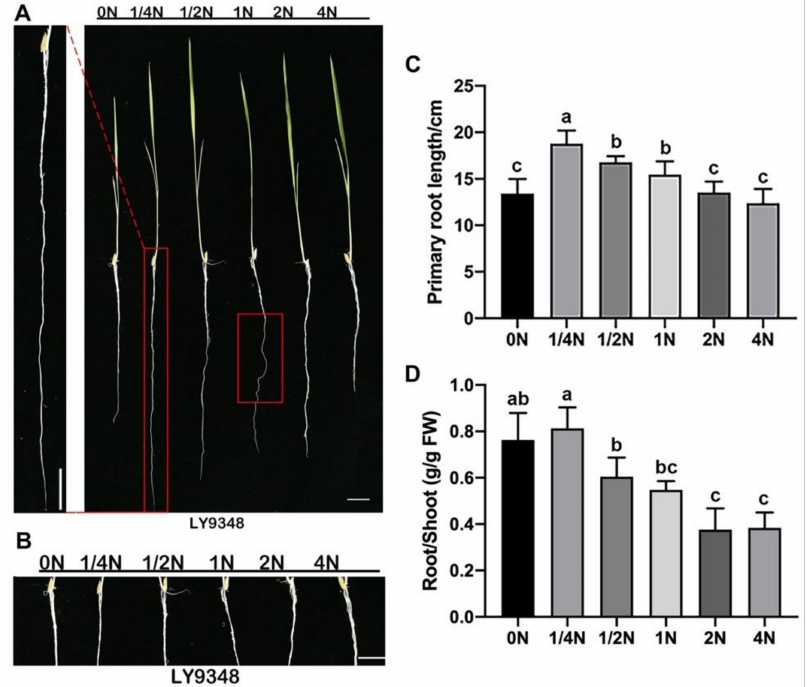
Figure 1. Phenotypic characteristics of LY9348 after different N dosage treatments. ( A ) Morphological characteristics of LY9348 at six N concentrations; ( B ) characteristics of LRs of LY9348 at six N concentra- tions; ( C ) PR length of LY9348 at six N concentrations; ( D ) the root-to-shoot ratio in fresh weight (FW g/g) at six N concentrations. Bars represent the standard error (SE; n = 3). Different letters